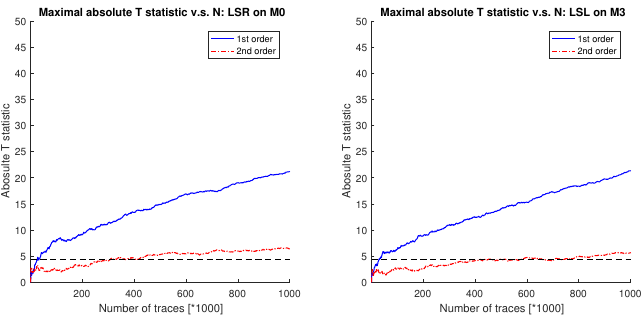
Figure 11: Instruction-wise leakage analysis without external resistor: 2-share LSL on M3/LSR on